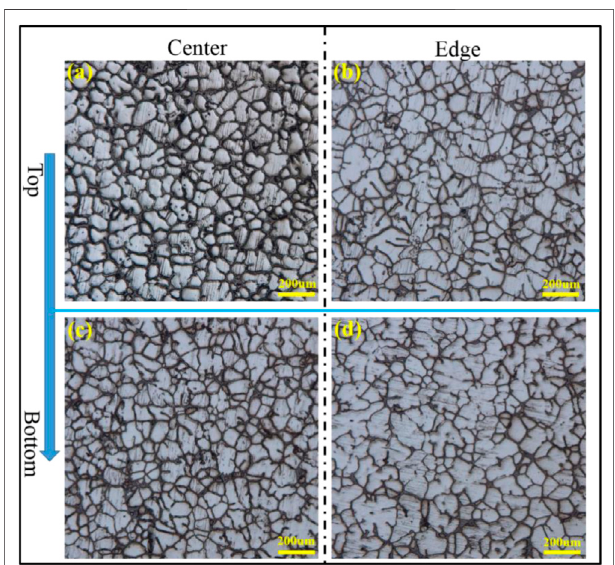
FIGURE5| OpticalmicroscopyimagesoftheTiC/2219 nanocomposite at the (A) upper center, (B) upper edge, (C) lower center, and (D) lower edge positions.